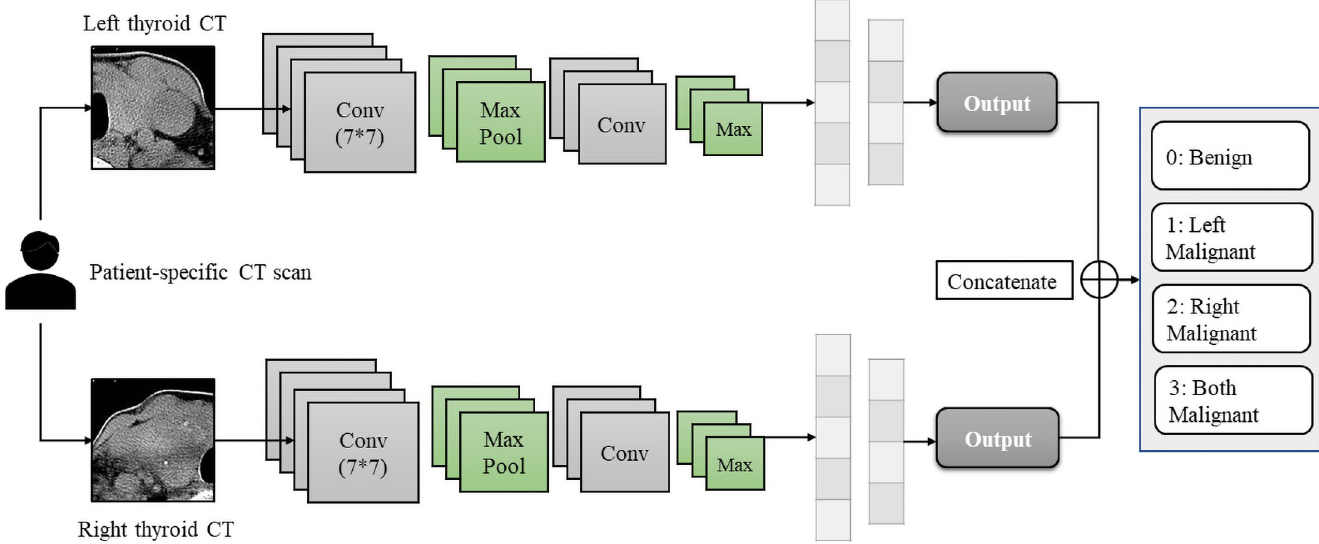
Fig 4. Double inputs dual-channel